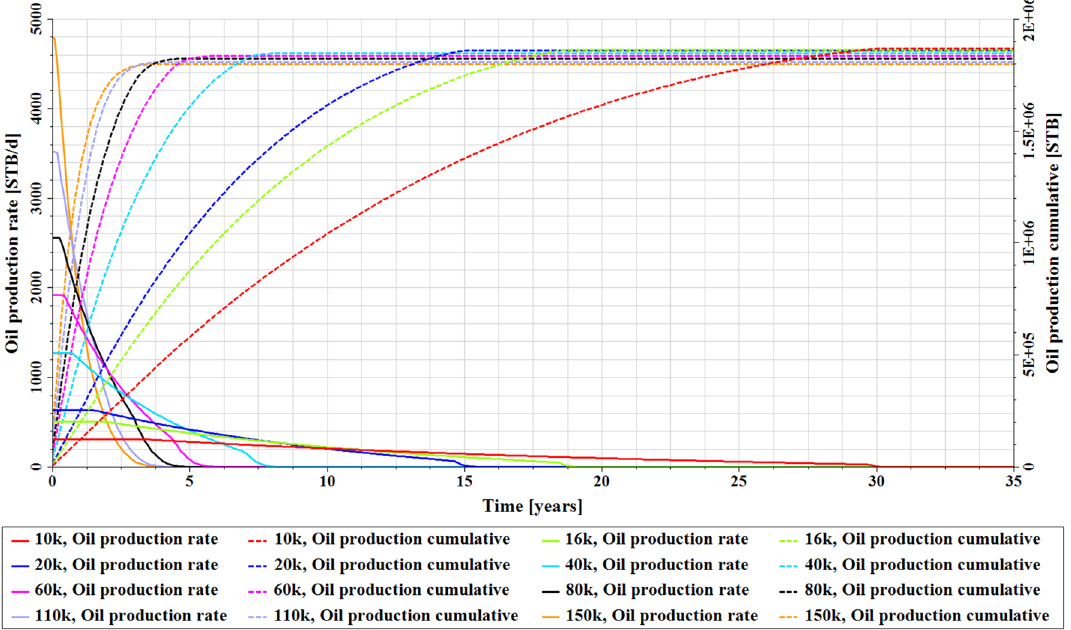
Fig. 19 Oil productions vs. time for different gas production